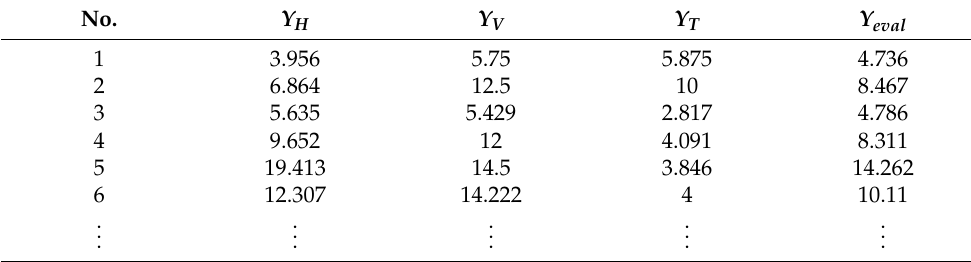
Table 10. Multi-objective evaluation value of the painting processes